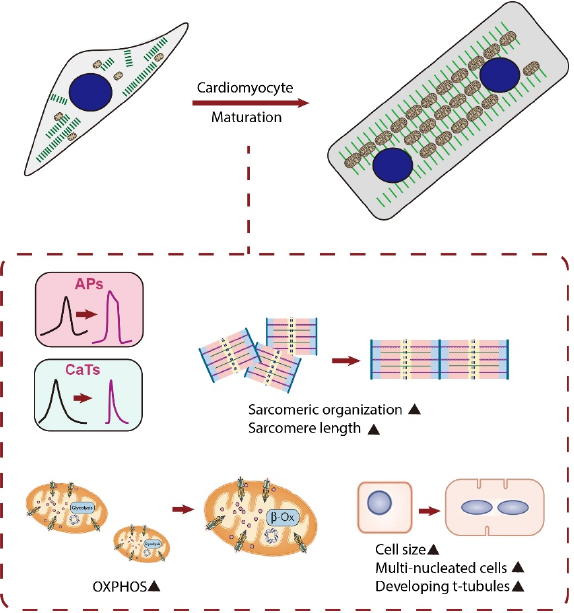
Figure 1. Schematic diagram showing major changes in characteristics of CMs during maturation. Matured CMs have an increased cell size, and the cell shape changes from circular to rod-shaped. Matured CMs have an improved alignment of sarcomeres, longer sarcomeres, and existence of t- tubules and become multi-nucleated. They also have enhanced calcium handling, electrophysiol- ogy, and metabolism. APs, action potentials; CaTs, calcium transients; OXPHOS, oxidative phos- phorylation; β -Ox, β -oxidation.